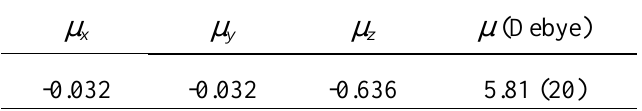
Table 4. Magnitude of the molecular dipole moment